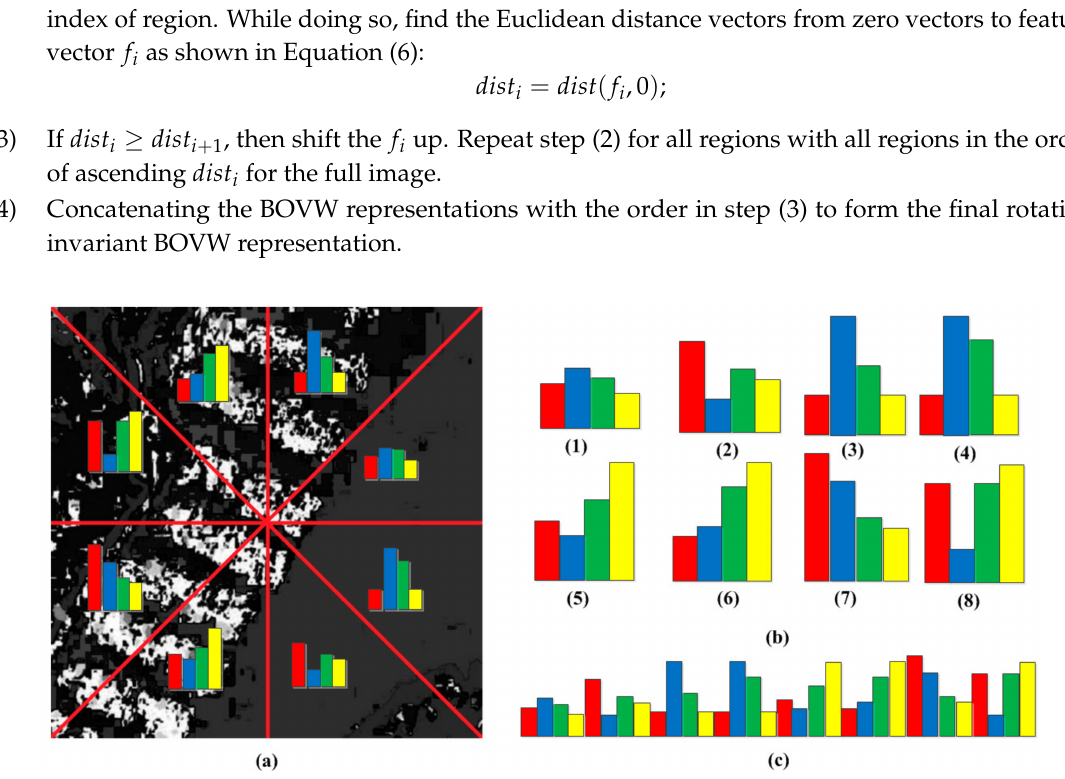
Figure 5. A graphical representation of Rotation invariant BOVW representation. ( a ) The partitions of images in rotation invariant BOVW representation; ( b ) BOVW representation in an ascending order of distance between zero vector and feature vector in each patch; and ( c ) the final rotation invariant BOVW